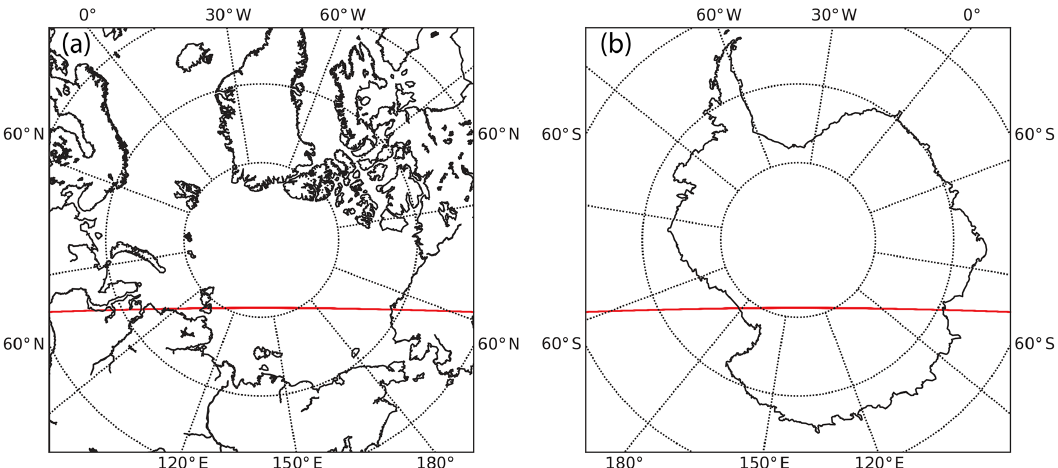
Figure 3. (a) Arctic map showing footprints (red line) of the tangential points at tangential heights of 80–85km. (b) Same as (a) , but for an Antarctic map. It should be noted that the center longitude is the sub-satellite longitude of Himawari-8: 140.7 ◦ E.